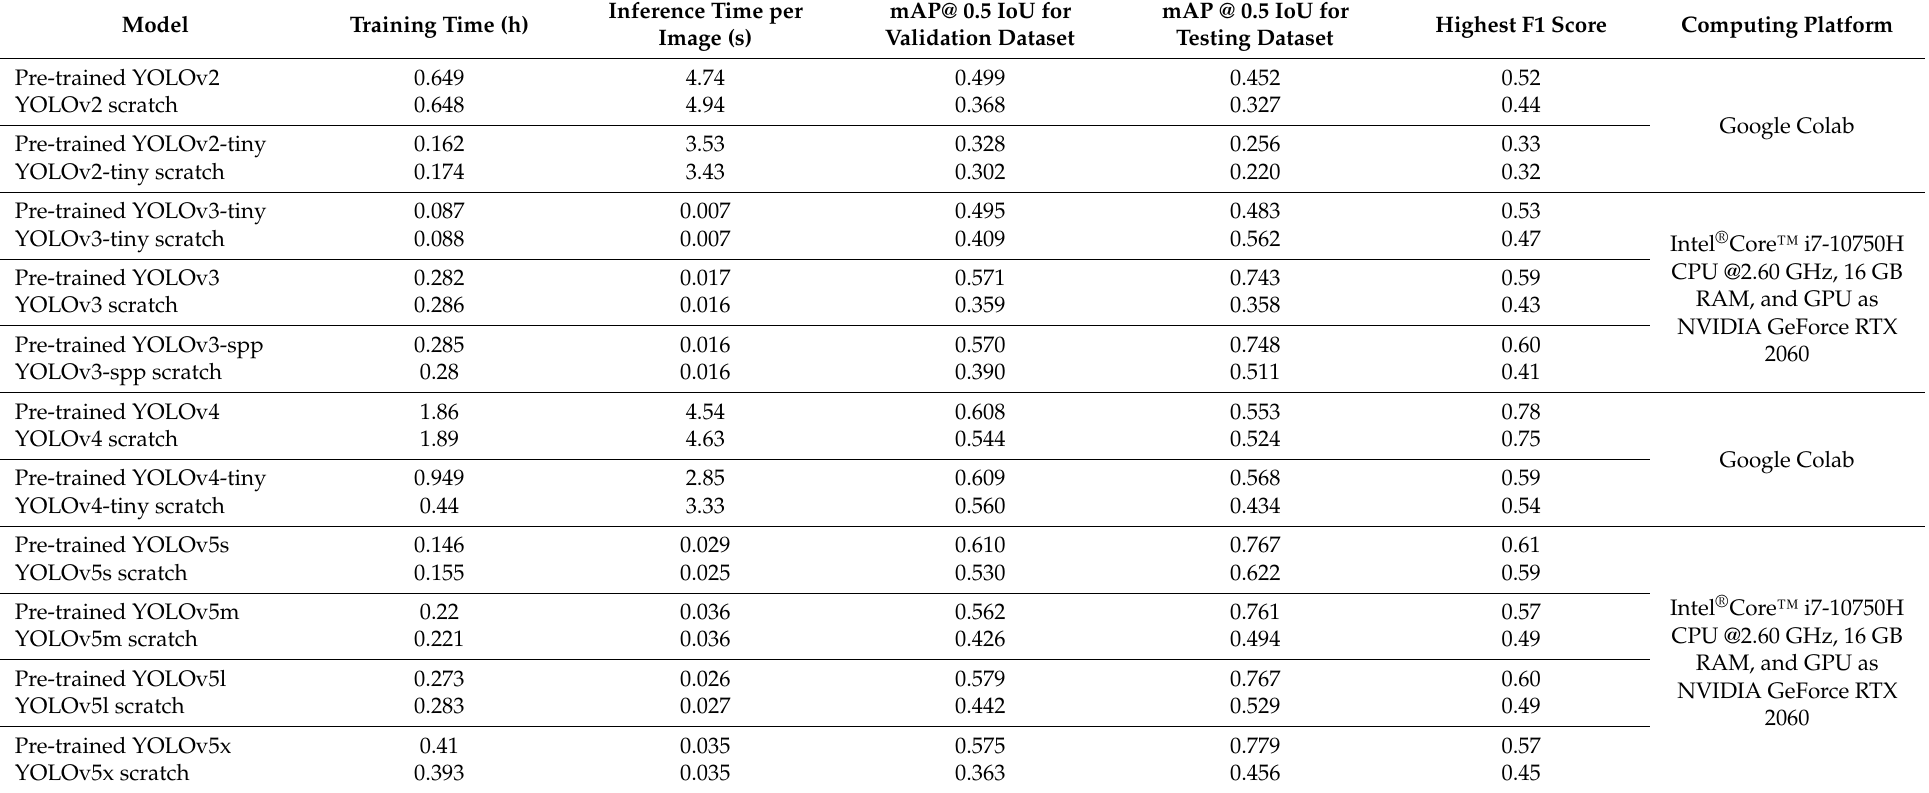
Table 4. Experiment III and IV results. Detection Performance on Talad Thai